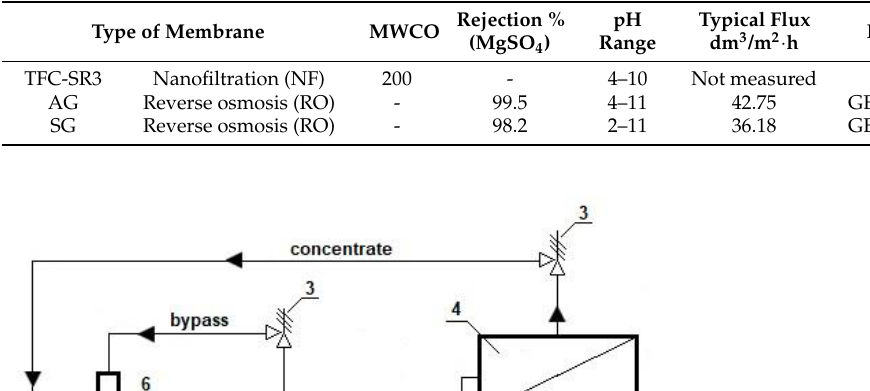
Table 2. Comparison of the NF and the RO membranes.